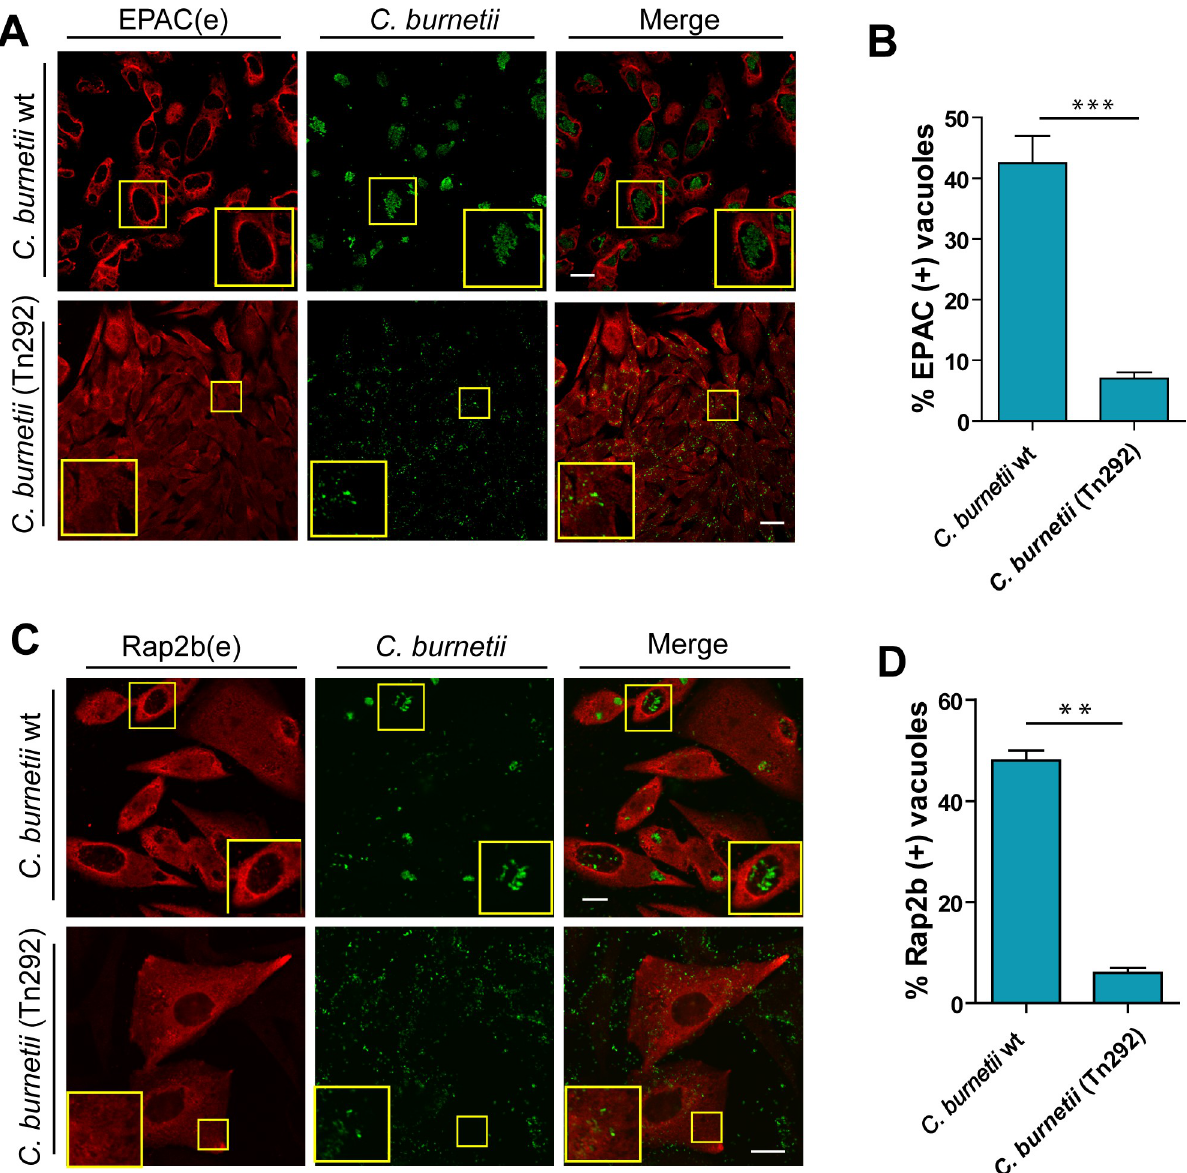
Fig 4. EPAC and Rap2b recruitment is dependent on the bacterial secretion system. A. CHO cells were infected with GFP- C . burnetii and GFP -C . burnetii DotA mutant (Tn292) (MOI = 10). After 48 h of infection, cells were fixed and analyzed by immunofluorescence using specific antibodies against EPAC (red). Cells were then analyzed by confocal microscopy. B. Percentage of CRVs labeled with EPAC from images like the ones depicted in panel A. Data are expressed as mean ± S.E.M. of at least three independent experiments (n > 50 cells/group). C. CHO cells were infected with GFP- C . burnetii and GFP -C . burnetii DotA mutant (Tn292). After 48 h of infection, cells were fixed and analyzed by immunofluorescence using specific antibodies against Rap2b (red). Cells were then analyzed by confocal microscopy. D. Percentage of CRVs labeled with Rap2b from images like the ones depicted in panel A. Data are expressed as mean ± S.E.M. of at least three independent experiments (n > 50 cells/group). Scale bar: 10 μ m.